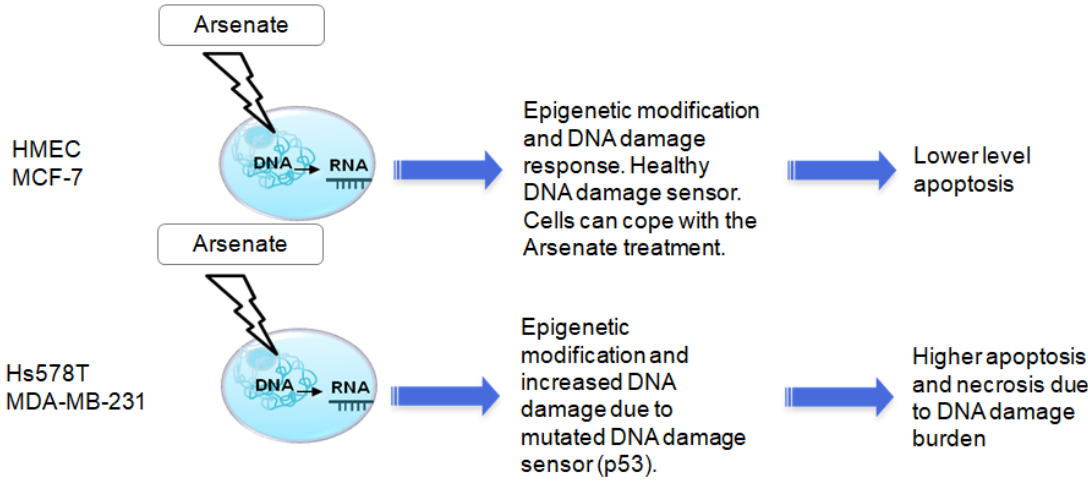
Figure 9. The putative mechanism of action and cell line selectivity of arsenate for HMEC and MCF-7 cells compared to Hs578T and MDA-MB-231; HMEC and MCF-7 cells have intact DNA repair and are hence better able to cope with this type of damage, while TNBC cell lines are known to be TP53 mutant and therefore arsenate causes increased apoptosis and